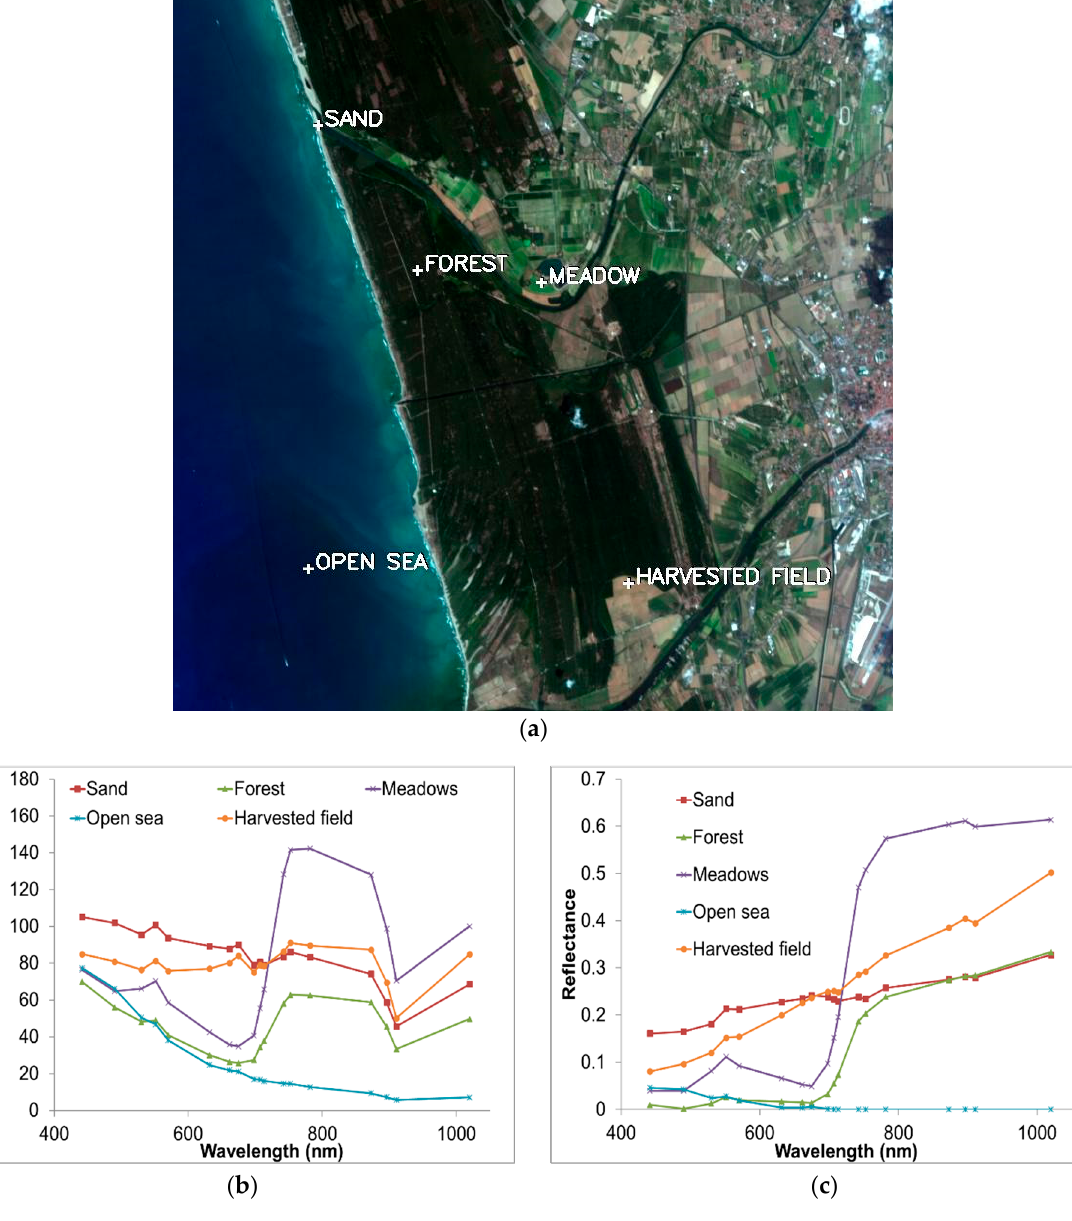
Figure 10. At-sensor radiance image for VZA = 0 ◦ acquired over the San Rossore Park on 25 July 2003 ( a ). At-sensor radiance spectra and spectral reflectance for natural and manmade targets extracted form a set of reference targets are plotted respectively in ( b , c